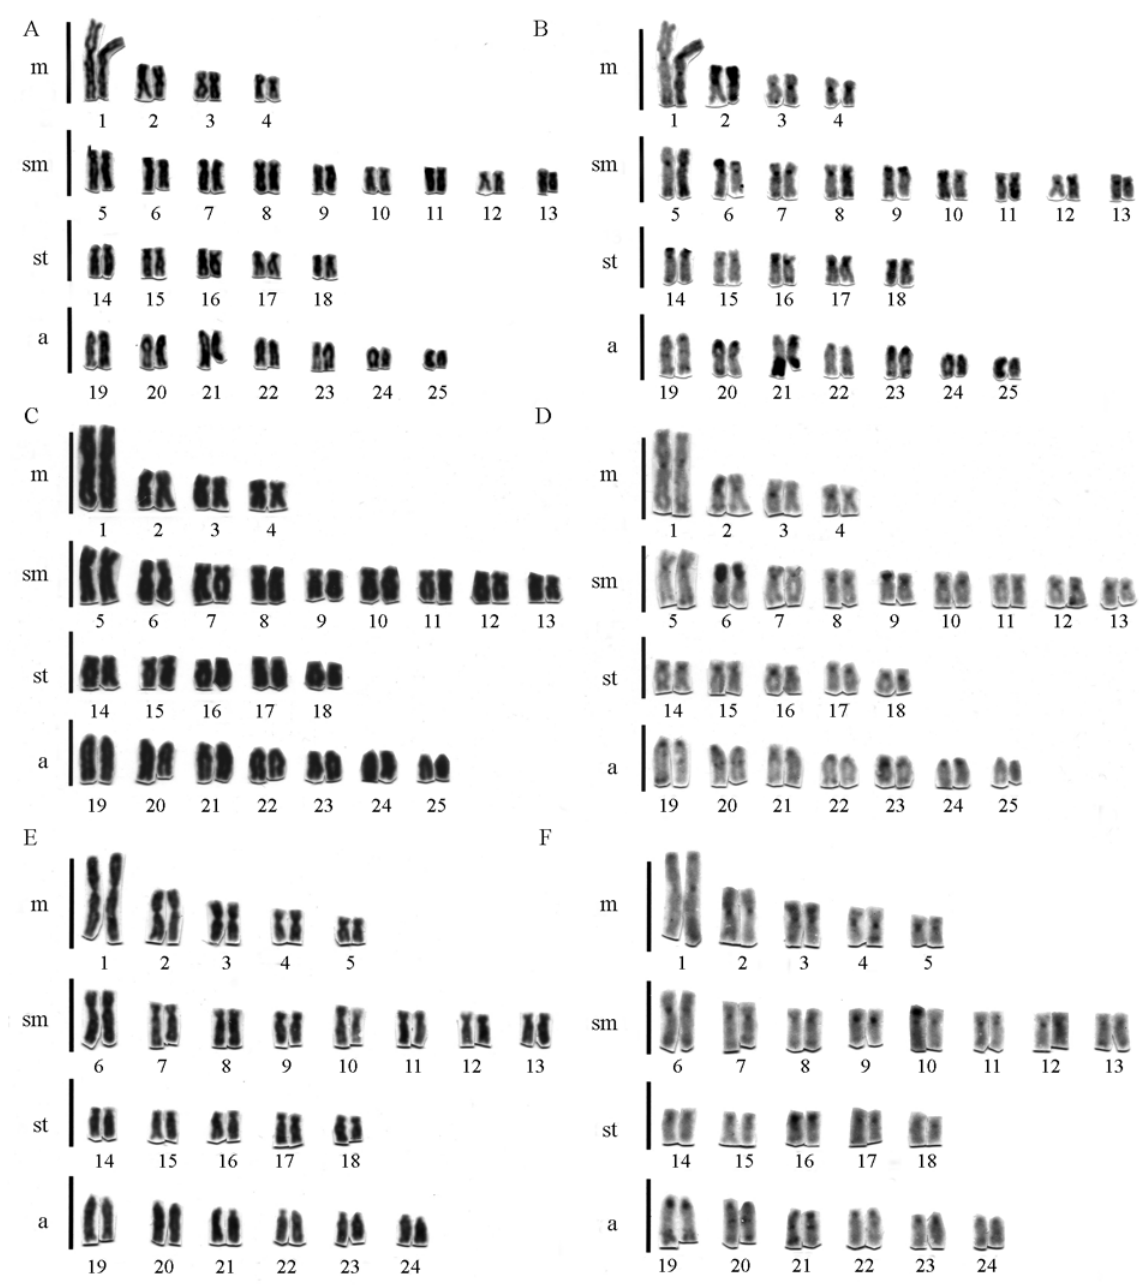
Figure 1 - Karyotypic forms of the Astyanax scabripinnis species complex: (A, B) Karyotype A ( Astyanax paranae ) from the Verde and Açungui Rivers; (C, D) Karyotype B (unidentified species) from the Santo Antônio River; (E, F) Karyotype C (unidentified species) from the Santo Antônio River. (A, C, E) conventional Giemsa staining, and (B, D, F) sequential C-banding, respectively. Bar represents 10 μ